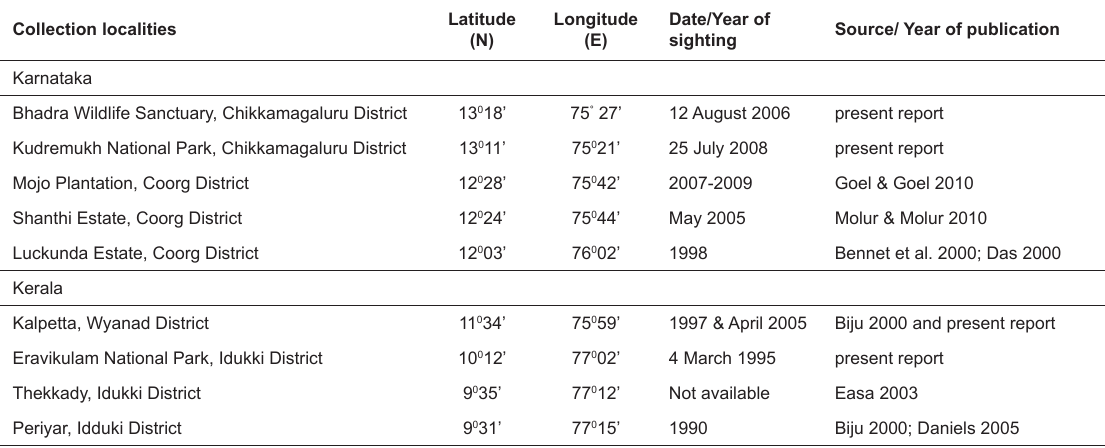
Table 2. Collection/sight localities of Rhacophorus lateralis in the Western Ghats